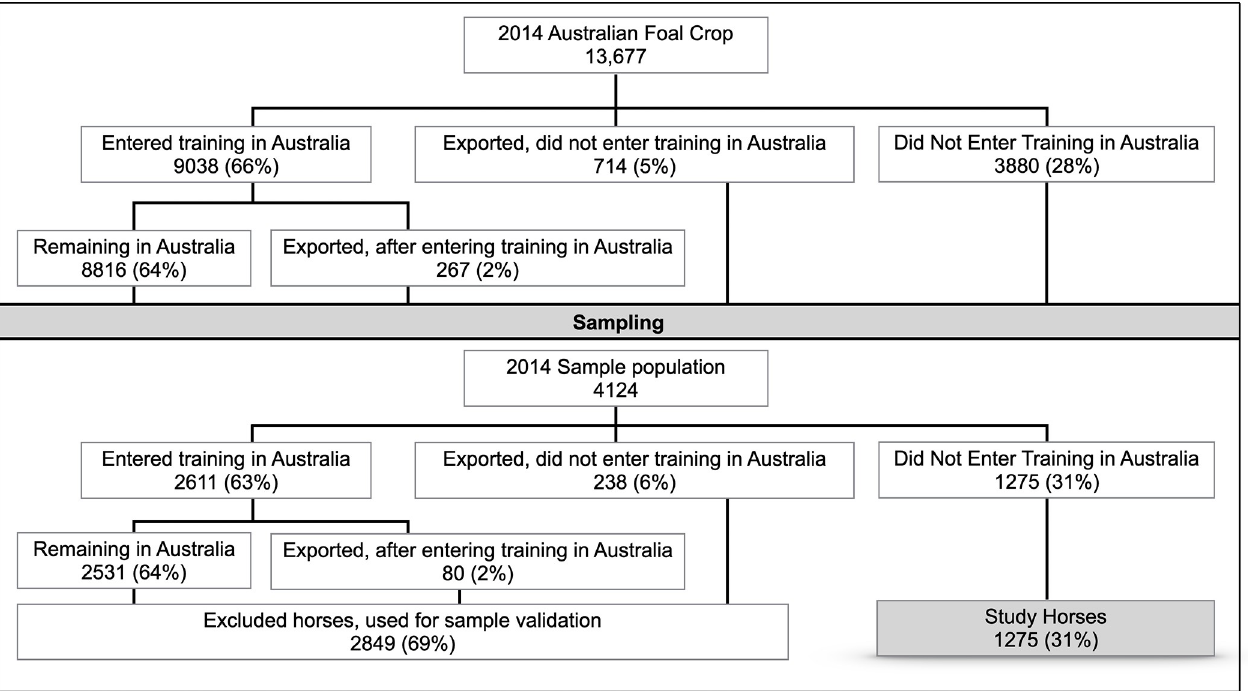
Fig 2. Flow chart of the highest level of training within Australia achieved for the 2014 Australian foal crop and sample population prior to the start of the 4-year-old racing season.